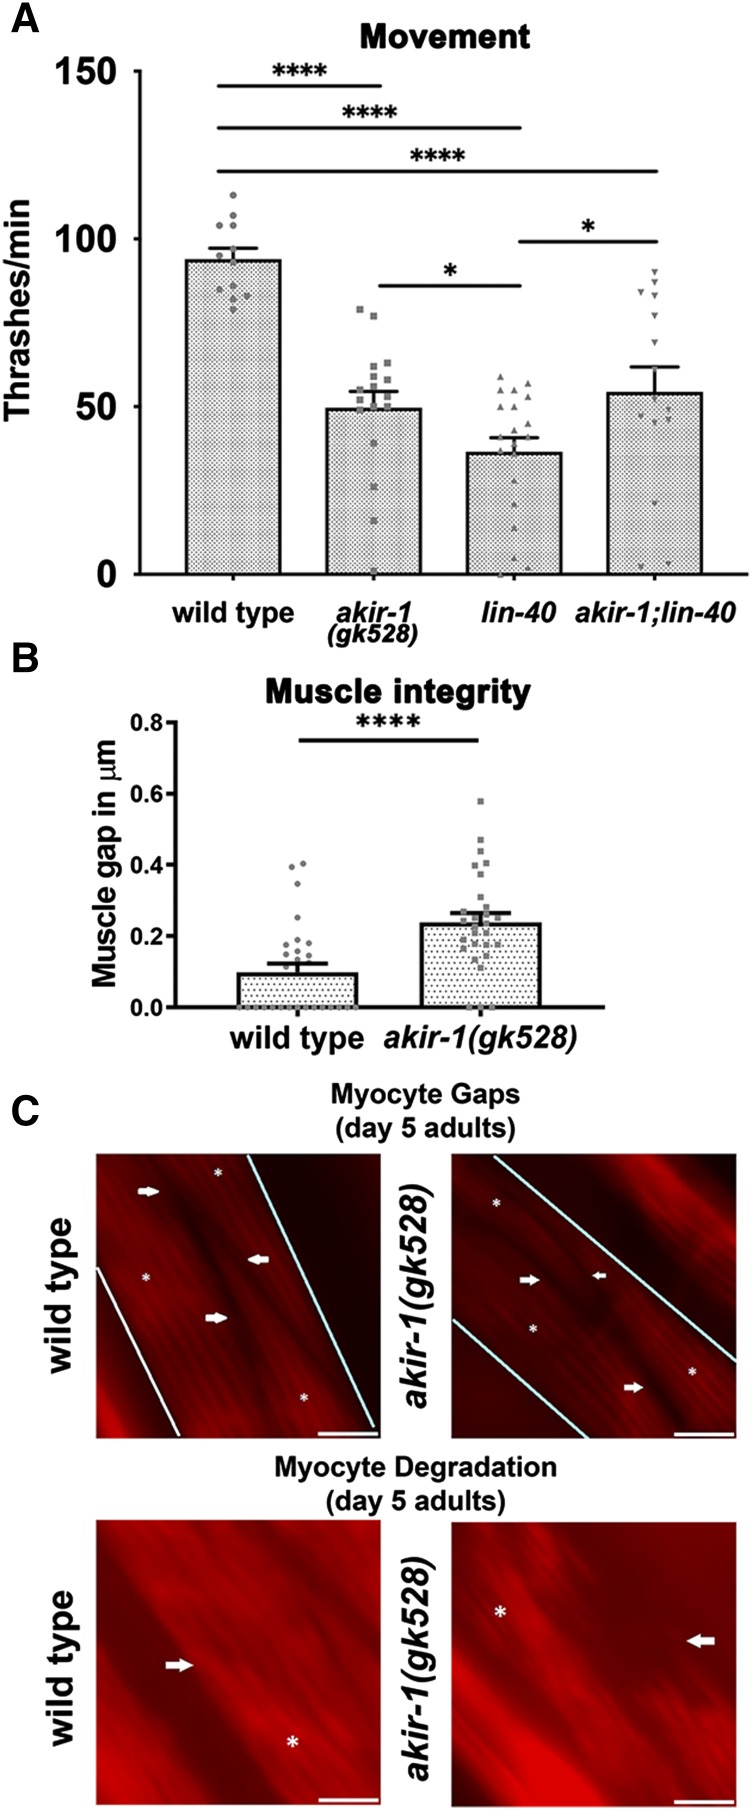
AKIR-1 is required for muscle function. A) Quantification of movement was done by counting full sinusoidal thrashes of C. elegans while suspended in M9. The data plot individual measurements and indicate the mean plus SEM, and n= 12, 17, 20 and 15 for wild type, akir-1, lin-40 and akir-1;lin-40 respectively. B) Muscle integrity was determined by measuring the distance between individual myocytes in the body wall muscle. Individual measurements are plotted with n = 28 and the mean plus SEM is shown. C) Images of body wall muscle myocytes at 5 days post larval adult. For myocyte gap distance, the body wall muscle is indicated within blue lines, individual myocytes are indicated by an asterisk (*), and the myocyte gap is shown by the white arrows. For muscle integrity, individual myocytes are indicated by an asterisk (*) and degraded muscle tissue is indicated with white arrows. Scale bars 10μm. * 0.01 ≤ P ≤ 0.05, *** 0.0001 ≤ P < 0.001, ****P < 0.0001.